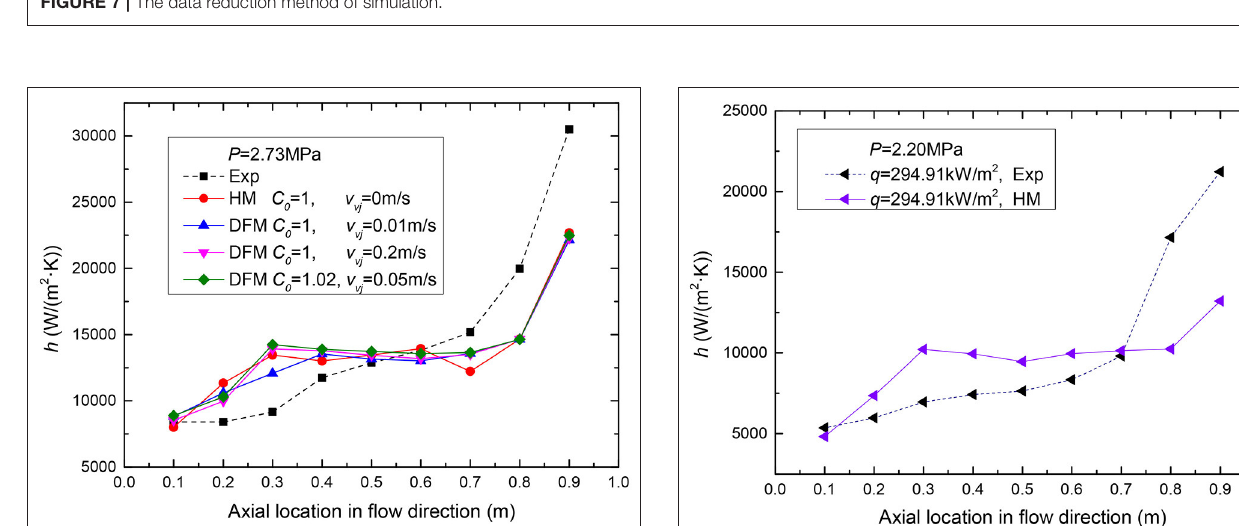
FIGURE 7 | The data reduction method of simulation.